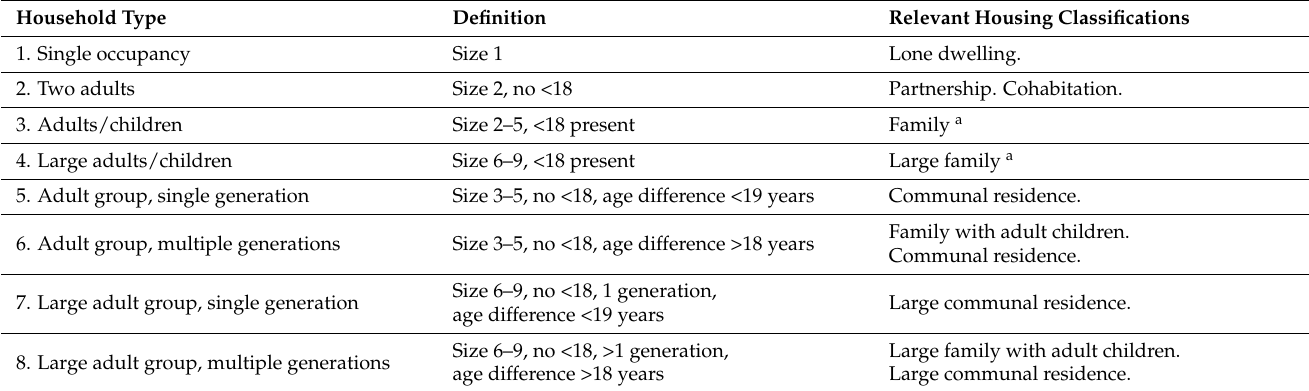
Table 1. Description of household categories used to assess COVID-19 vaccine